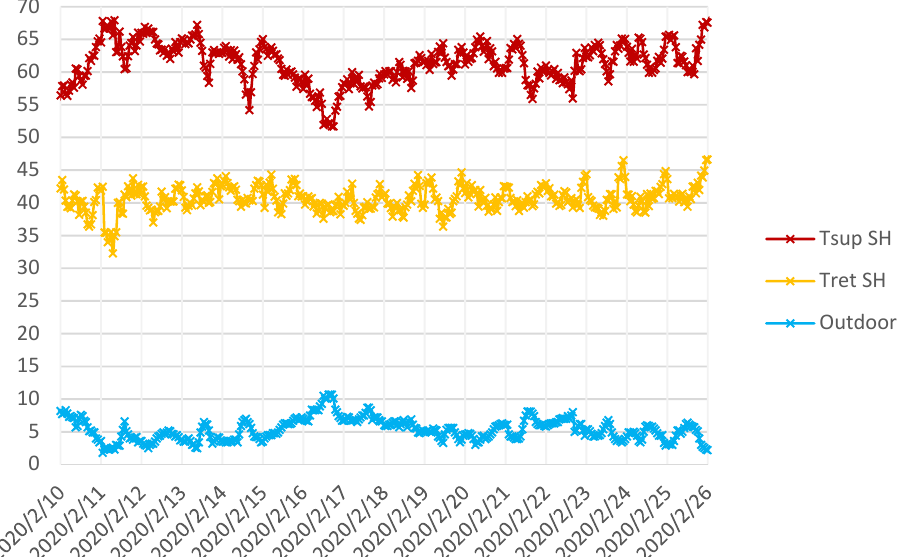
Figure 12. Hourly measurements of supply and return temperatures in the space heating system during the test of prototype 1 in February 2020.